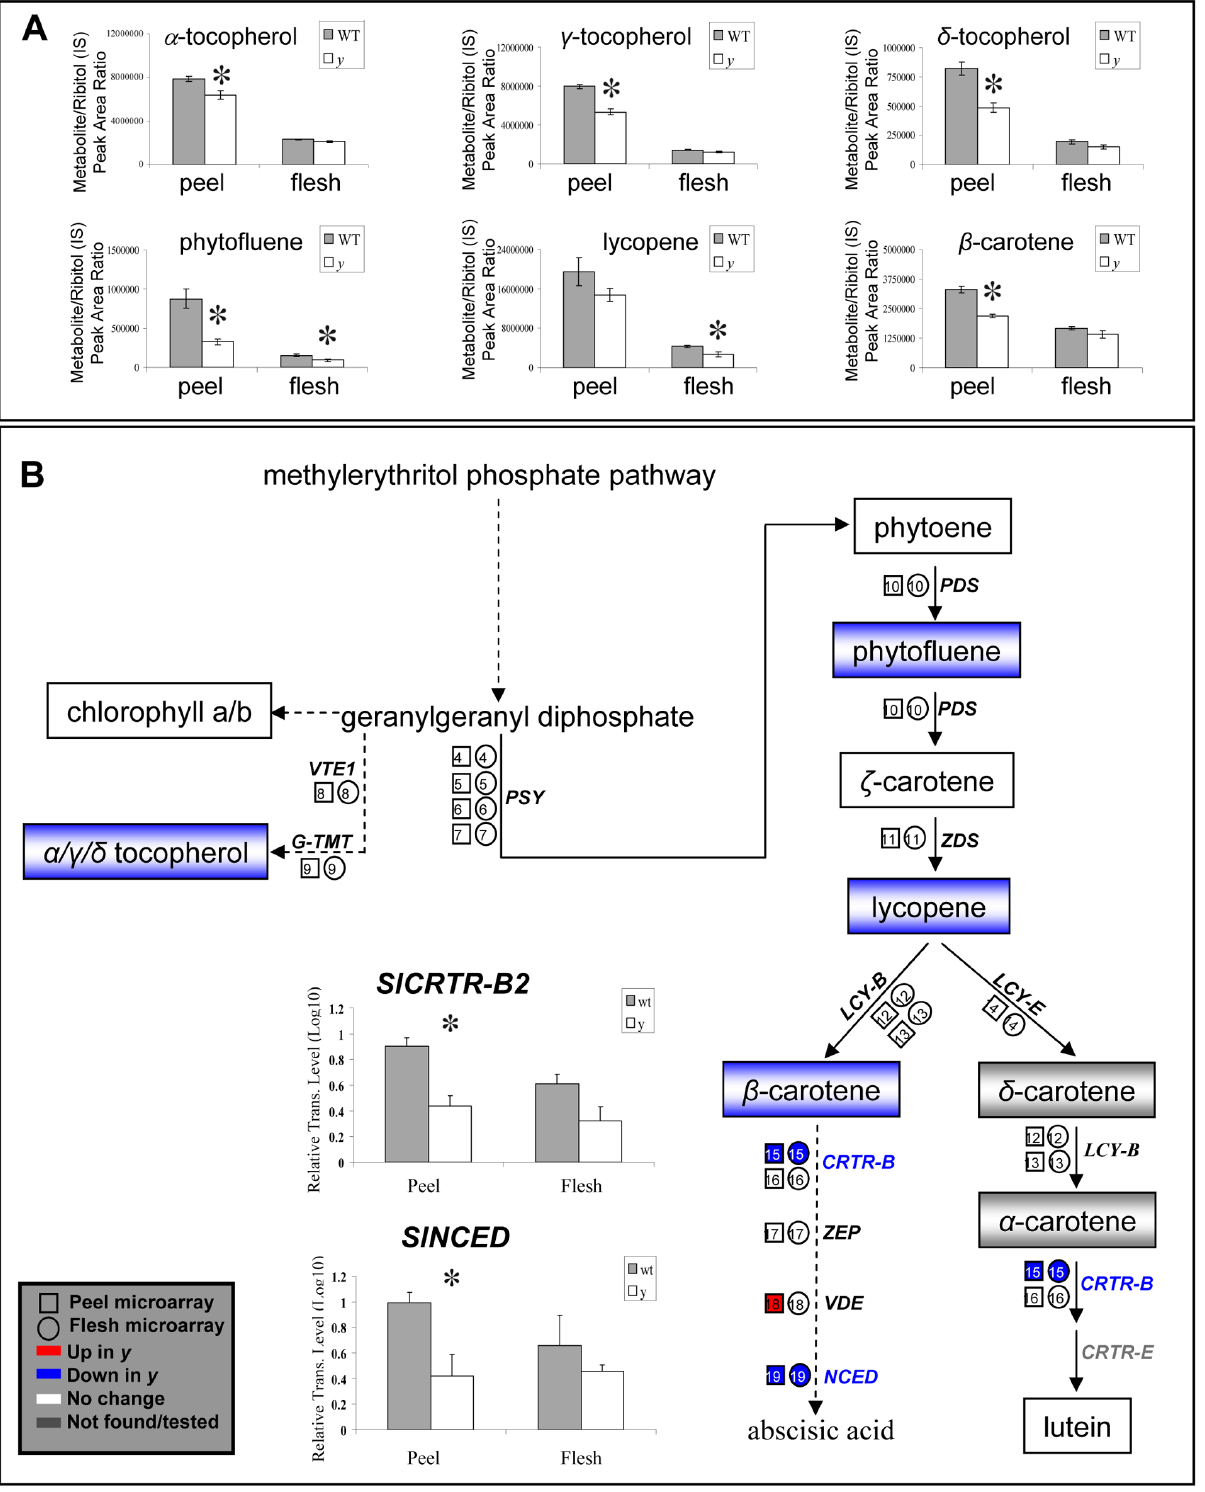
Figure 7. Changes in metabolite and gene-expression levels in the isoprenoid pathway detected in y mutant fruit tissues. (A) HPLC- PDA analysis detected six isoprenoids that differ significantly between the wt and y mutant fruit tissues at the orange stage of fruit development. Indicated by asterisks are significant differences analyzed by Student’s t-test (n=3; P , 0.05; bars indicate standard errors). (B) Changes in isoprenoid- related gene expression (detected by array analysis) and metabolite levels (detected by HPLC-PDA) in tomato fruit peel and flesh tissues. Red and blue colors represent up- and down-regulation, respectively. Significant down-regulation of SlCRTR-B2 and SlNCED transcript levels in the y mutant peel was confirmed by RT–PCR analyses (Student’s t-test, n=3; P , 0.05; bars indicate standard errors). Primers, transcript identifiers/accessions and expression data are listed in Table S4.